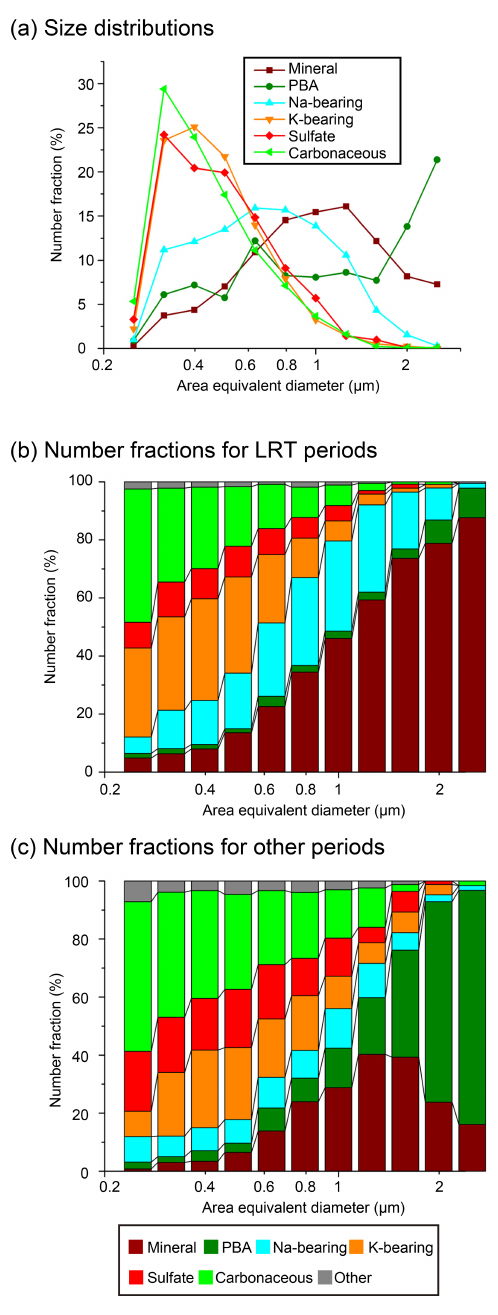
Figure 5. Size distributions and number fractions of each aerosol type. (a) Size distributions of each aerosol particle type among all samples. The y axis shows the number fractions for each bin. Num- bers are 2519 (mineral), 557 (PBA particles), 1806 (Na-bearing par- ticles), 2223 (K-bearing particles), 1120 (sulfate), 2289 (carbona- ceous particles), and 221 (other; not shown). Size-dependent num- ber fractions of each aerosol particle type for (b) LRT periods and (c) other samples. Numbers are 7769 (LRT periods) and 2966 (other periods). Size bins are shown on a log scale, and the size ranges are less than 0.25, 0.25–0.32, 0.32–0.40, 0.40–0.50, 0.50–0.63, 0.63– 0.79, 0.79–1.00, 1.00–1.26, 1.26–1.58, 1.58–2.00, and greater than 2.00µm.